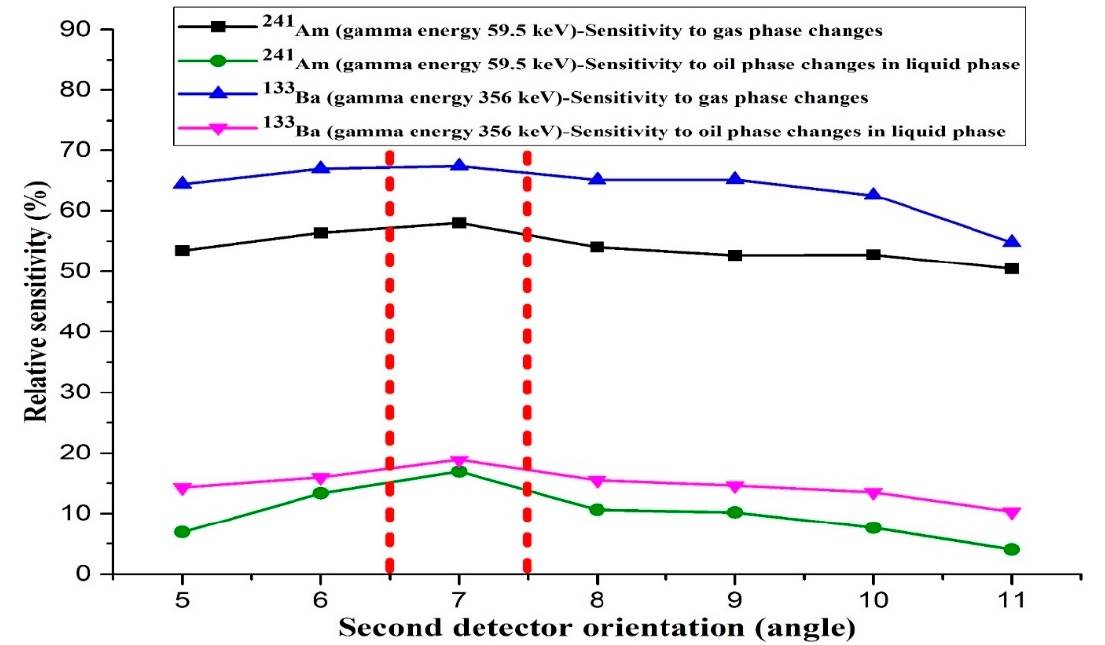
Figure 3. Sensitivity investigations results to find optimum position for the second detector.